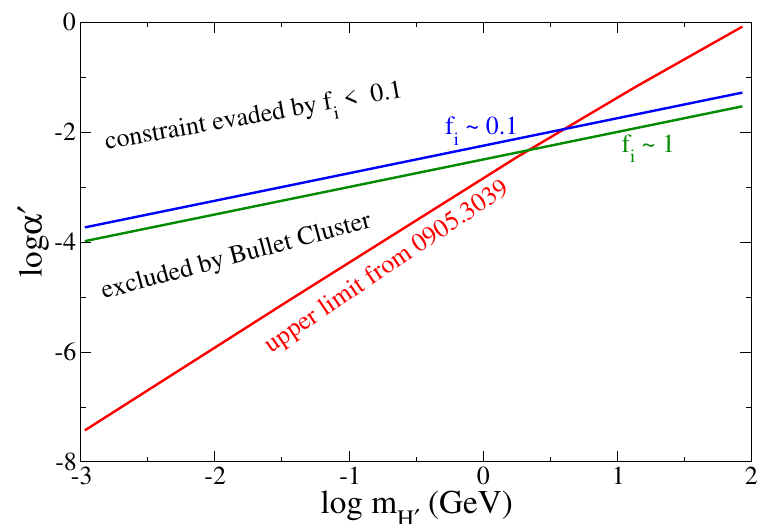
Figure 1: Region of dark atom parameter space excluded by Bullet Cluster bounds for models with R = 1 ( m